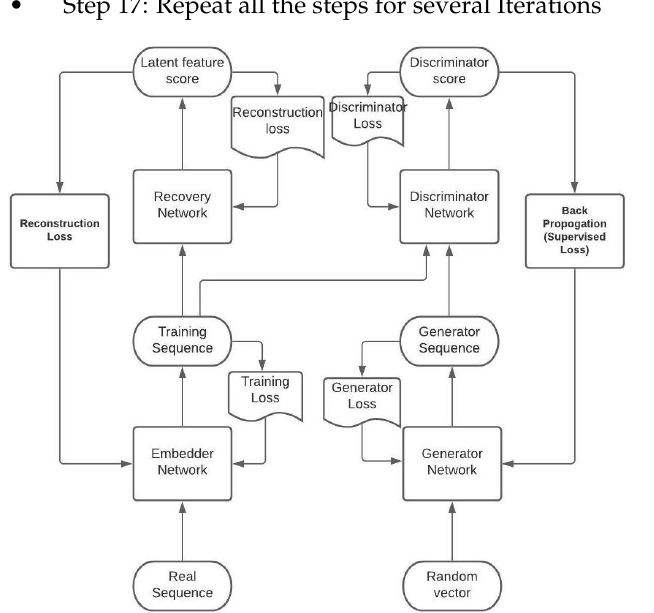
Figure 3. Time variant GAN training